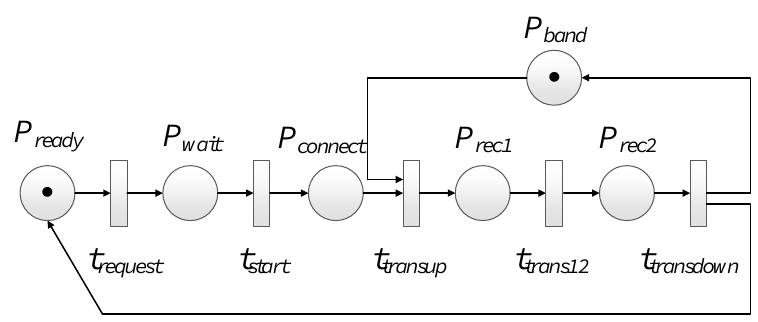
Figure 5. SPN model for the traditional satellite network.